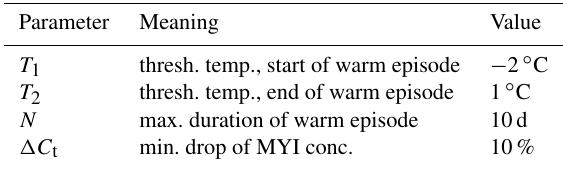
Table 2. Tuning parameter settings for the temperature correction